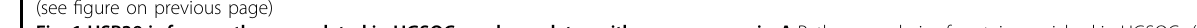
Fig. 1 USP39 is frequently upregulated in HGSOCs and correlates with poor prognosis. A Pathway analysis of proteins enriched in HGSOCs ( n = 10) compared with FTs ( n = 10) based on proteomics data. Samples were collected from Qilu Hospital, Shandong University. B Heat map showing expression levels of splicing factors upregulated in HGSOCs ( n = 6) compared with FTs ( n = 6) based on transcriptome microarray results (GSE135886). Samples were collected from Qilu Hospital, Shandong University. C , D USP39 mRNA expression was compared between HGSOCs and normal tissues from the TCGA cohort ( C ) and our cohort ( D ). E Representative images of immunohistochemical (IHC) staining of USP39 in our tissue microarray (containing 149 samples of HGSOCs and 41 samples of FTs collected from Qilu Hospital, Shandong University). F Statistical analysis of USP39 expression from IHC staining of our tissue microarray. High and low expression indicate the fi nal score of each sample determined by two pathologists based on the intensity and extent of staining across the tissue microarray section. HGSOC patients were dichotomized into low (Score ≤ 7) and high (Score >7) USP39 protein expression groups based on IHC staining score. G Kaplan – Meier analysis of the correlation between USP39 expression and clinical prognosis based on data from our tissue microarray. H Kaplan – Meier analysis of the effect of USP39 mRNA expression on the overall survival and progression-free survival of ovarian cancer patients based on an online cohort from Kaplan – Meier Plotter (http://kmplot.com/). The high and low expression groups were separated based on the best cutoff. P value was obtained by Student ’ s t -test ( C , D , F ) or Log-rank test ( G , H ). * P < 0.05, ** P < 0.01, *** P <